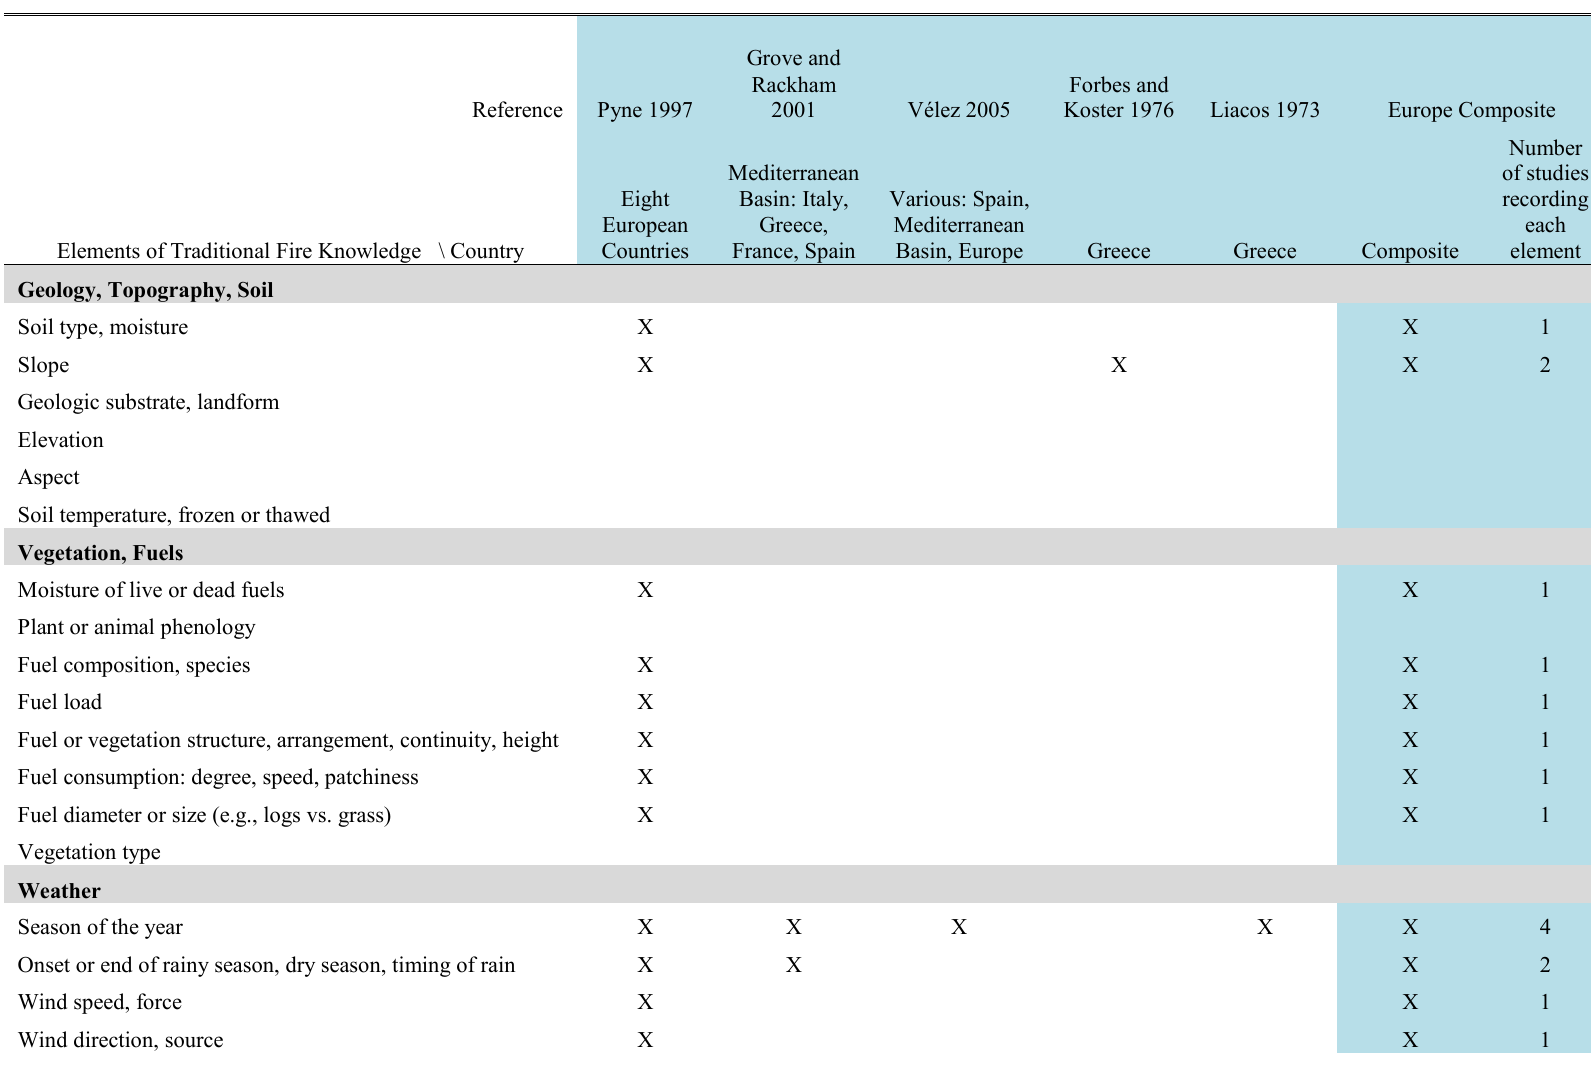
Table A.4. Elements of traditional fire knowledge recorded in studies from Europe (n=5). Elements tallied from Pyne (1997) included specific accounts from eight countries: Finland, France, Germany, Greece, Italy, Poland, Spain and